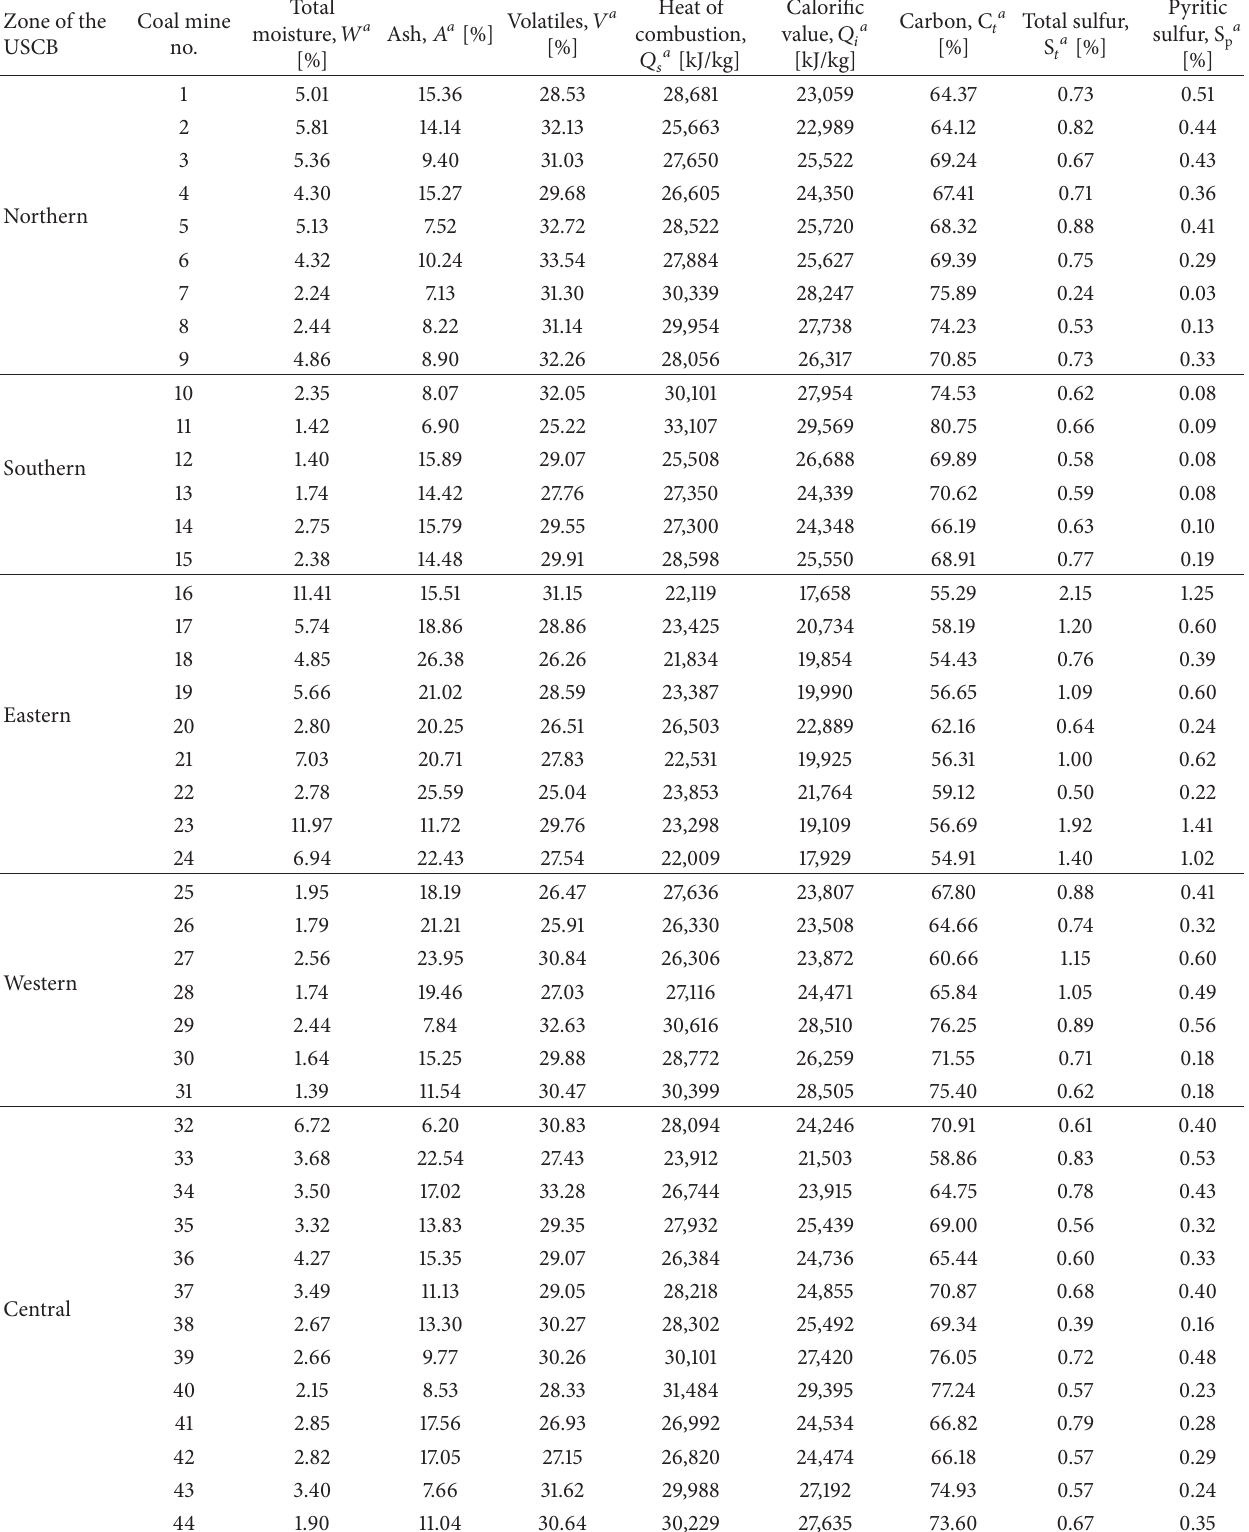
Calorific Carbon, C 𝑡𝑎 value, 𝑄 𝑖𝑎